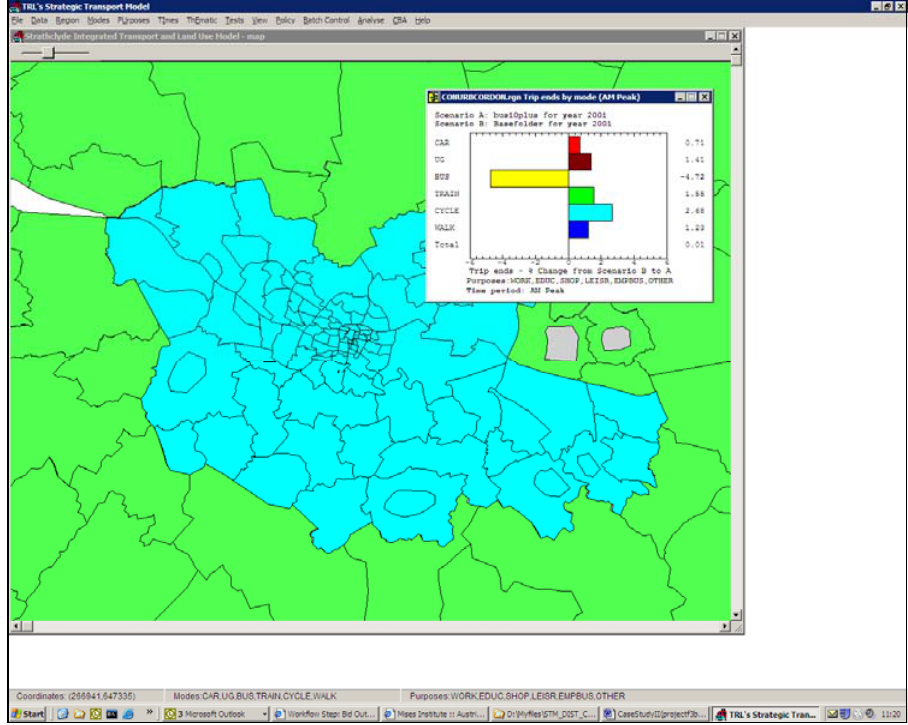
Figure 8. Screen dump showing Glasgow Conurbation and comparison between base and policy run